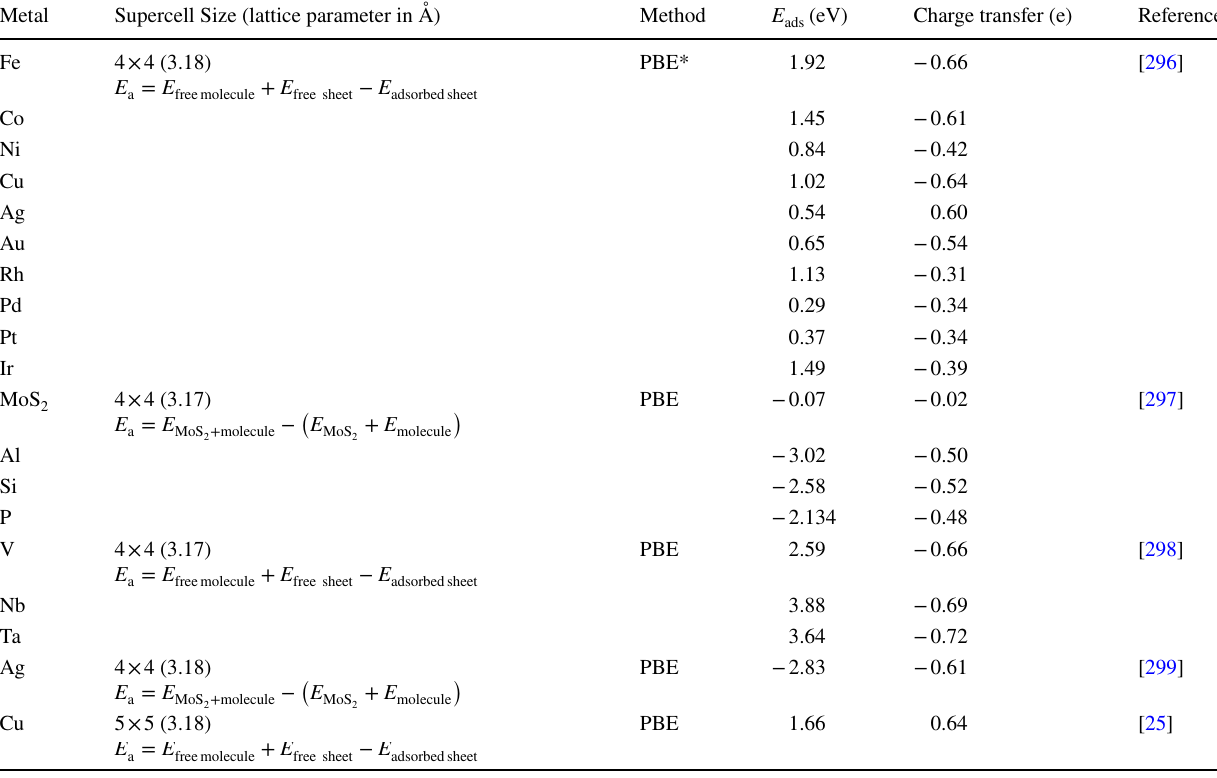
The Fe metal-embedded MoS NO adsorption properties with charge transfer value 2 − 0.66e and adsorption energies of 210 meV. The negative